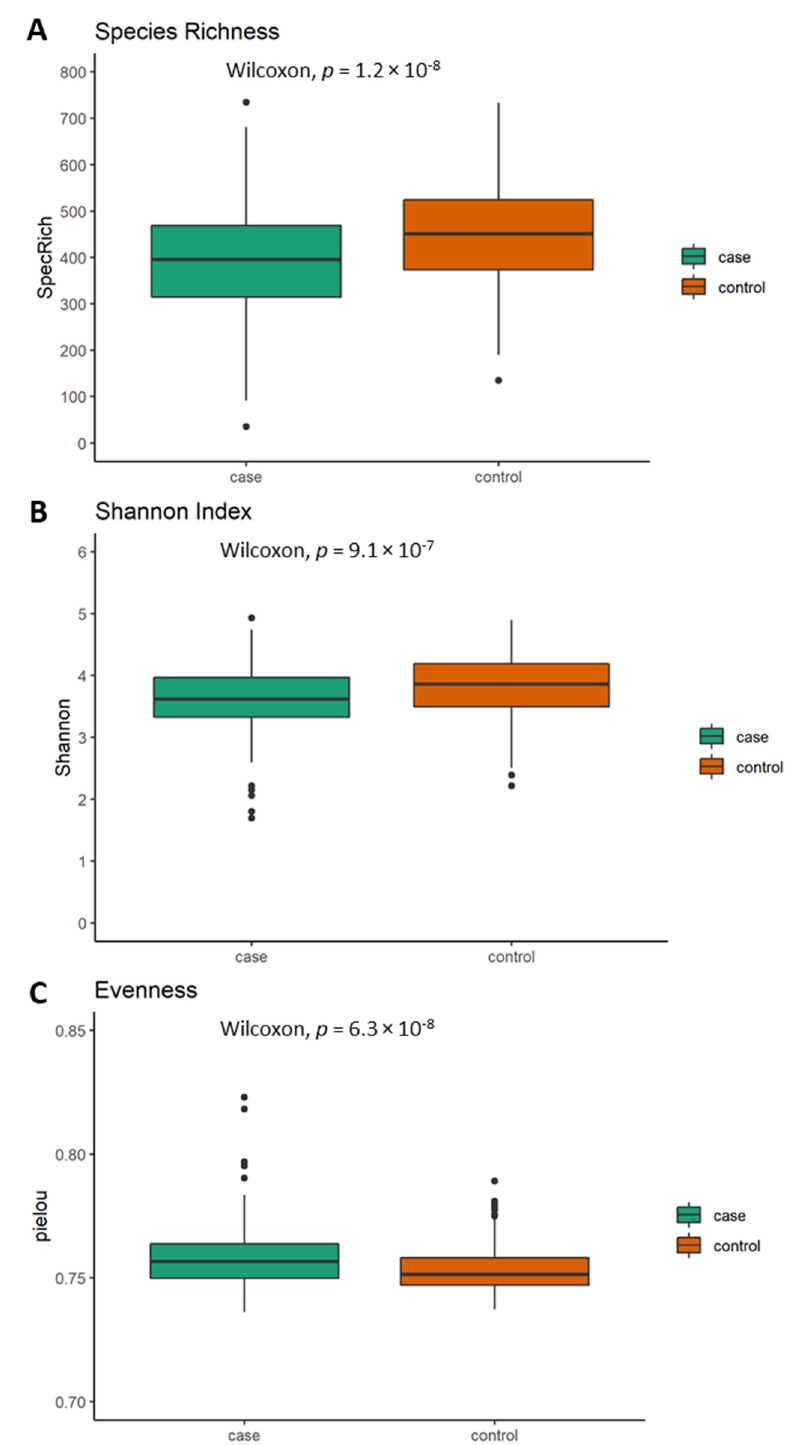
Figure 1. Alpha diversity and evenness differences between cases and controls displayed through three indices: ( A ) species richness, ( B ) Shannon index and ( C ) evenness (Pilou); (spot = outlier, Wilcoxon test; p < 5 × 10 − 2 ).